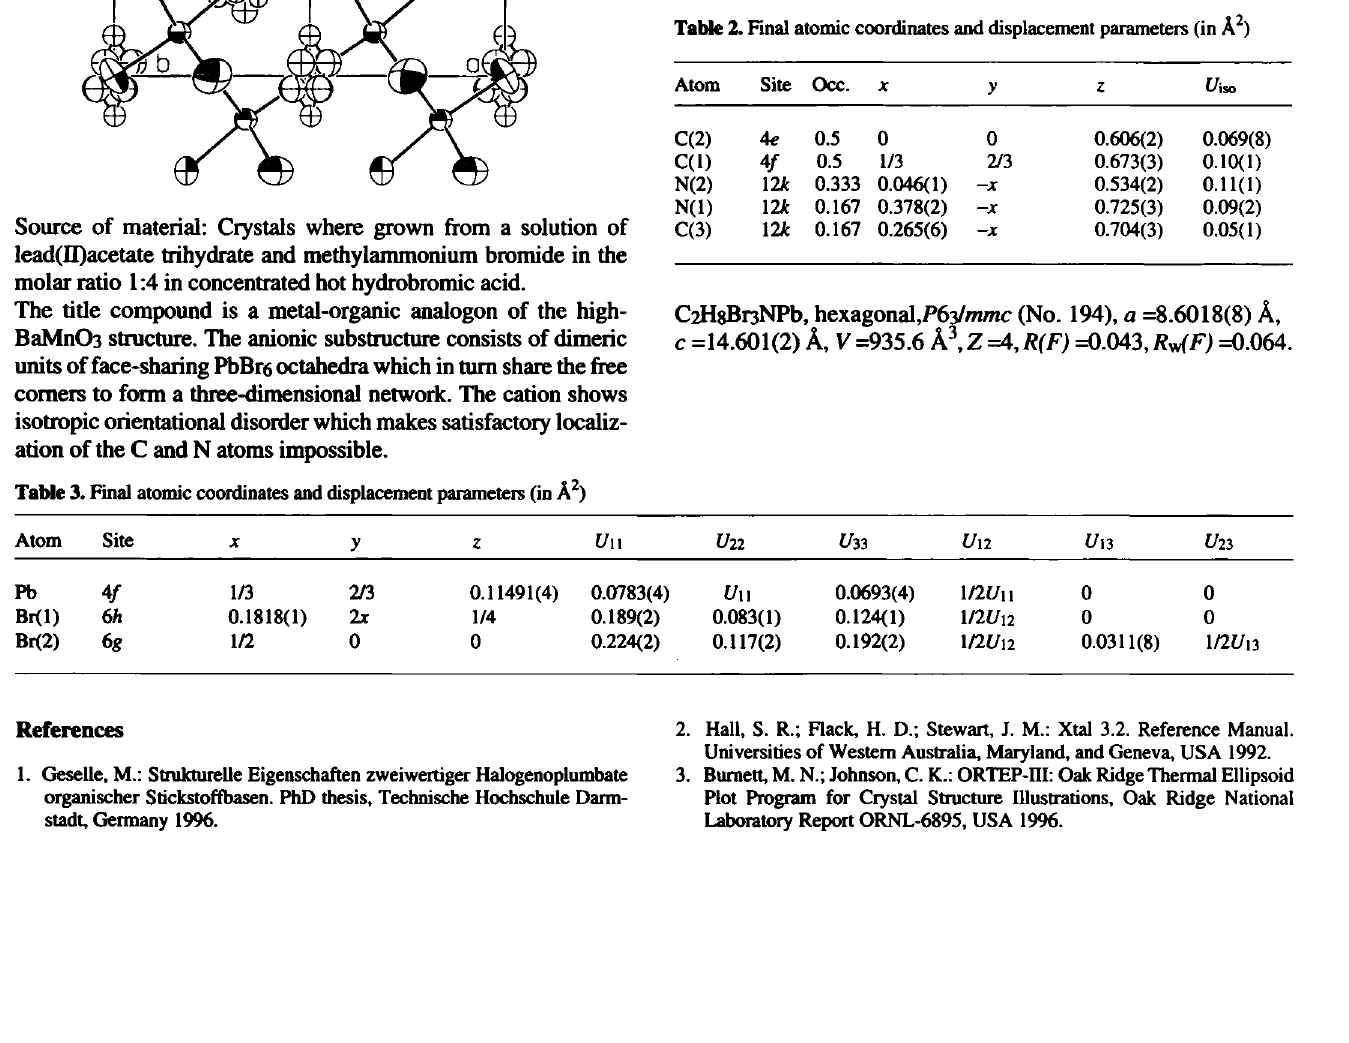
Table 2. Final atomic coordinates and displacement parameters (in Â 2